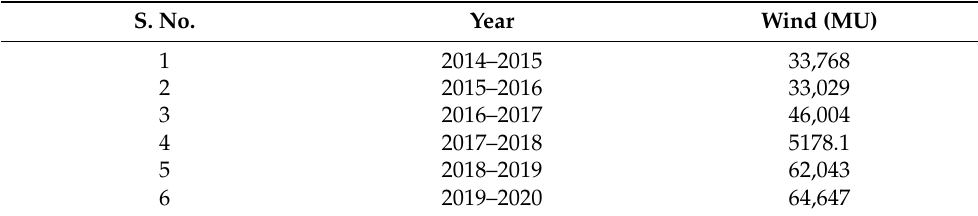
Table 18. Yearly electricity generation from wind energy (MU), from 2014 to 2020. Source: MNRE [66]. S. No.